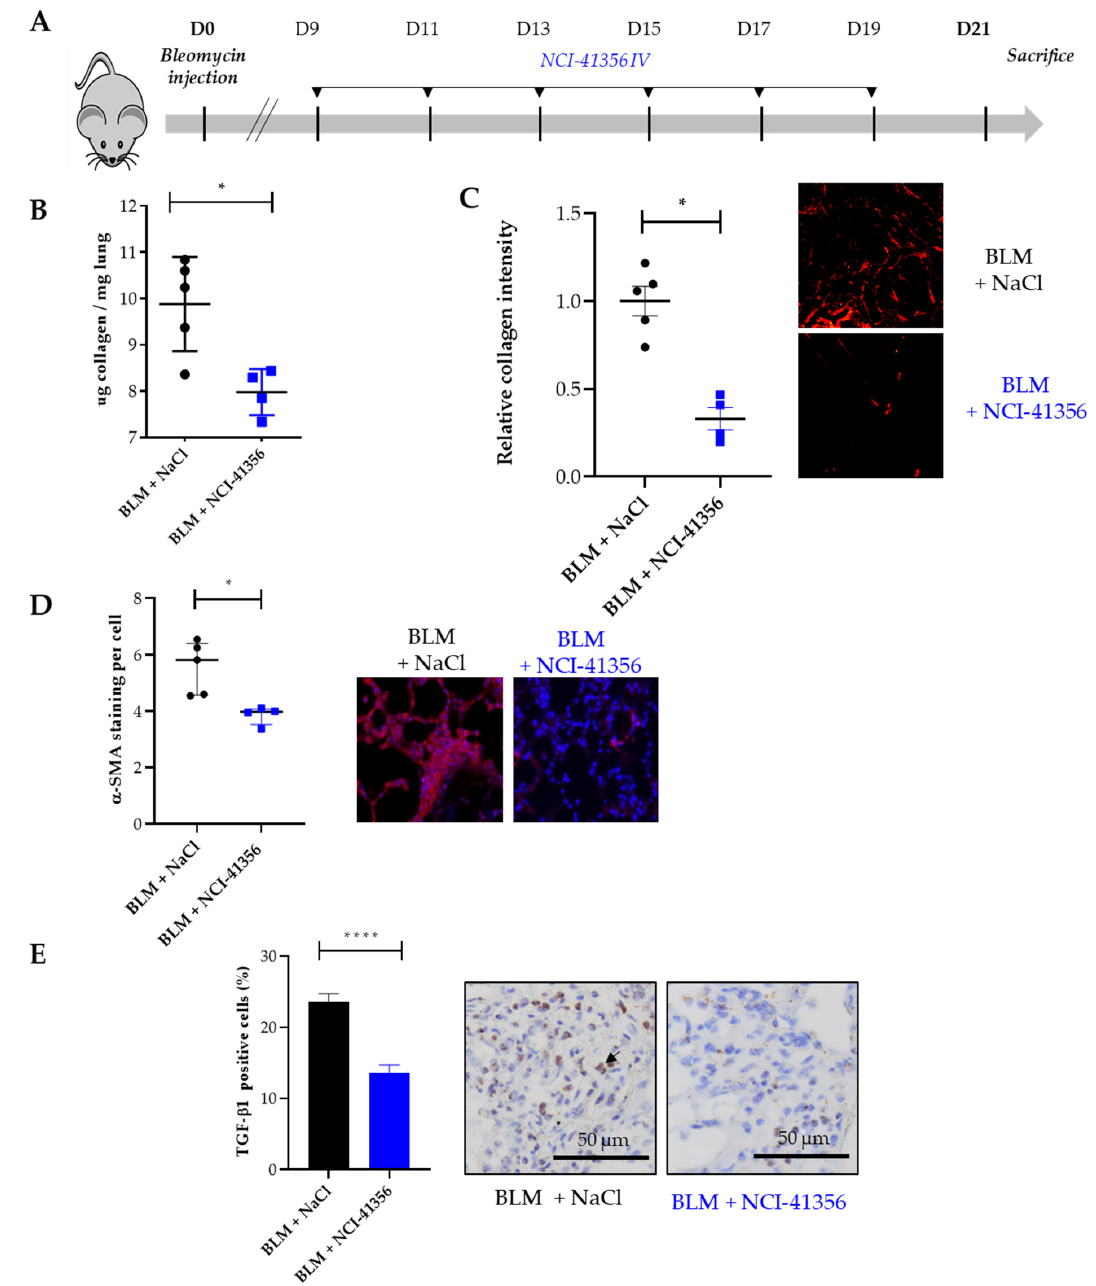
Figure 1. Intravenous administration of NCI-41356 reduces pulmonary fibrosis in bleomycin treated mice. A. Mice experimental injection plan between day 0 (D0), the day of bleomycin (BLM) injection (1.5 mg/kg) and the day of sacrifice (D21). Mice were treated with NaCl 0.9% ( n = 6) or NCI-41356 ( n = 6) (15 mg/kg) 3 times a week between day 9 and 21; B. Collagen quantification by Sircol assay (expressed as µg of collagen per mg of lung) of bleomycin treated mice lungs treated or not with NCI-41356 (* p = 0.0317); C. Collagen semi-quantification by Sirius Red staining performed on lung sections of mice treated by bleomycin with or without NCI-41356 (* p = 0.0159, control = 1); D. Quantification of α -SMA staining by immu- nofluorescence performed on lung sections of mice treated by bleomycin with or without NCI-41356 (* p = 0.0159); E. TGF- β 1 mRNA expression (brown color, black arrow) on lung tissues of mice treated by bleomycin with or without NCI-41356 (**** p < 0.0001)(×20). Data are expressed as means ± SEM and compared using nonparametric Mann–Whitney test (Figure 1B–D) or Welch’s test (Figure 1E).